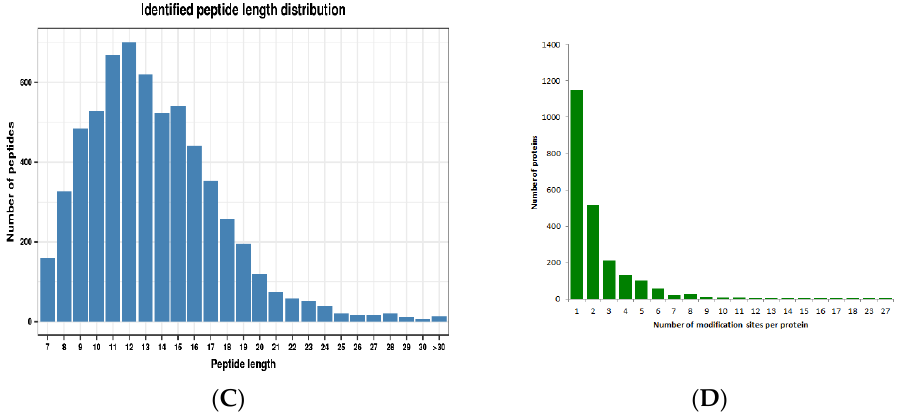
Figure 1. Identification of global crotonylation sites and proteins in paper mulberry leaves . ( A ) Ex- perimental workflow for the identification of lysine crotonylome . ( B ) Basic statistical table of MS results . ( C ) Number of each identified peptide length . ( D ) Number of each identified modified site in a protein. Table 1. Lysine crotonylome identified in paper mulberry and other plants.